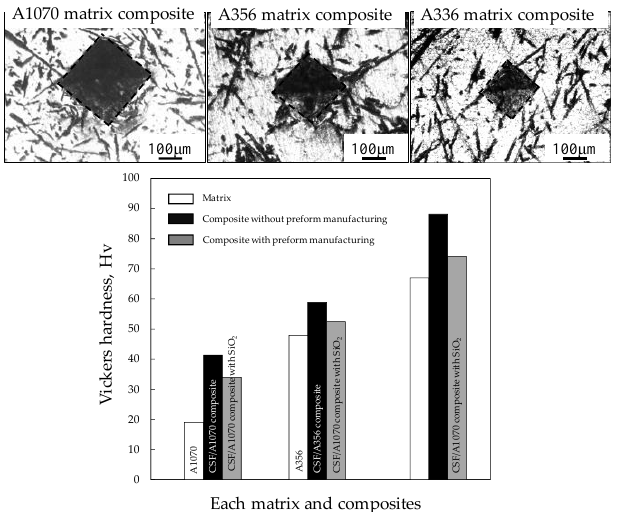
Figure 7. Vickers hardness of Ni plated CSF/Al and Al alloy matrix composites compared to composite of preform manufacturing with SiO 2 binder.